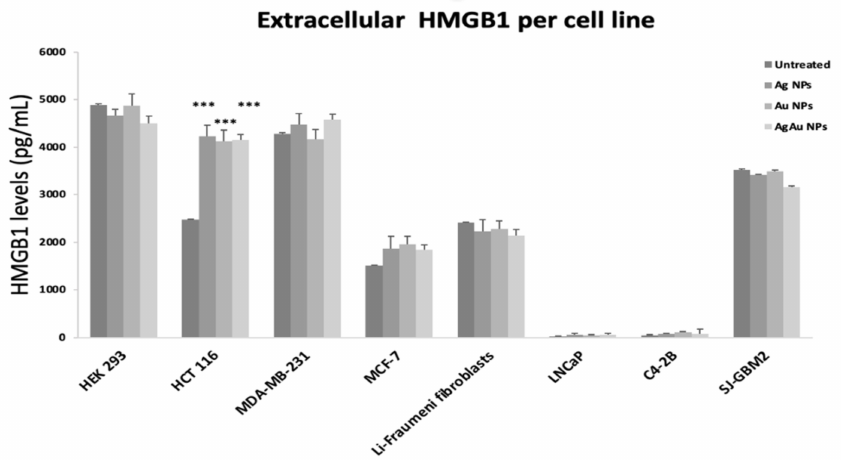
Figure 4. Extracellular levels of HMGB1 per cell line, after incubation with 50 µ g/mL of Ag, Au or AgAu NPs. The *** symbol shows statistical significance using one way ANOVA ( p < 0.05) compared to untreated